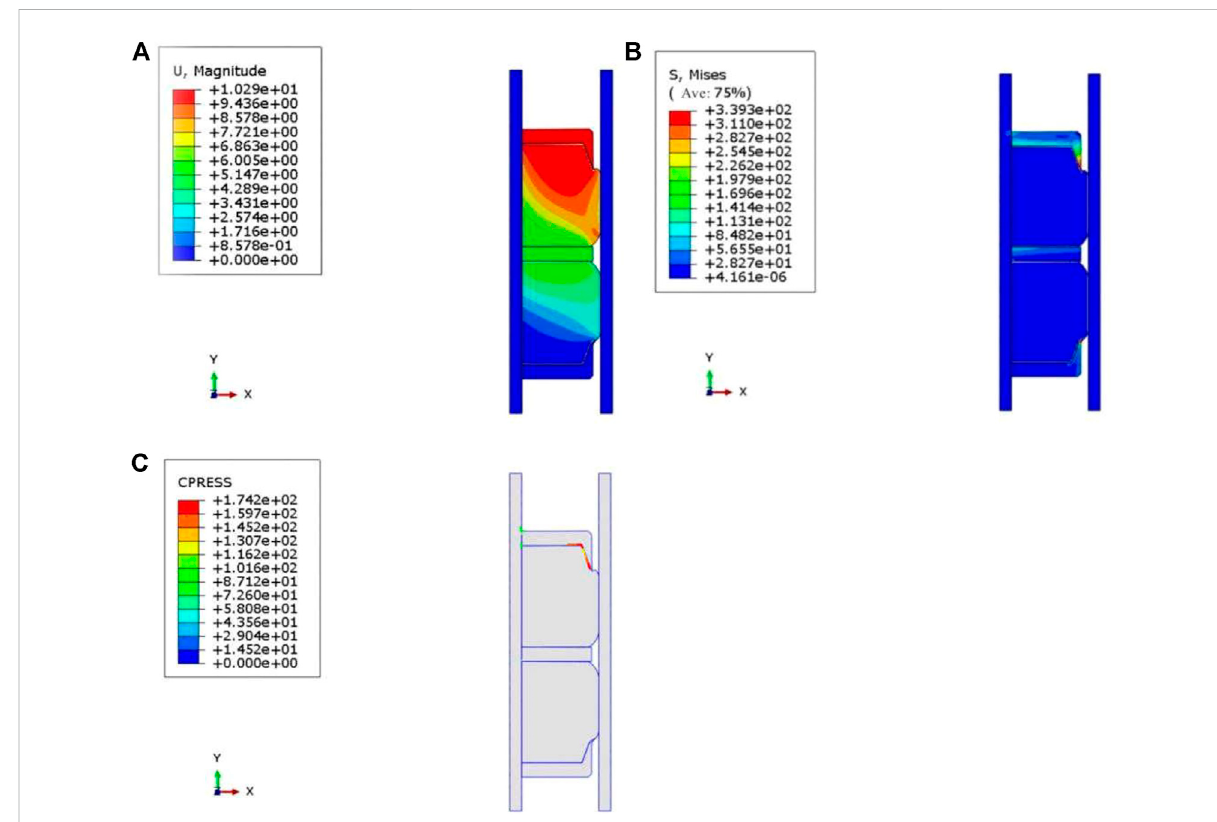
FIGURE 11 Simulation results of the stress distribution of the rubber cylinder. Notes: (A) Deformation cloud of the rubber cylinder; (B) Stress cloud of the rubber cylinder; (C) Contact stress cloud of the rubber cylinder.